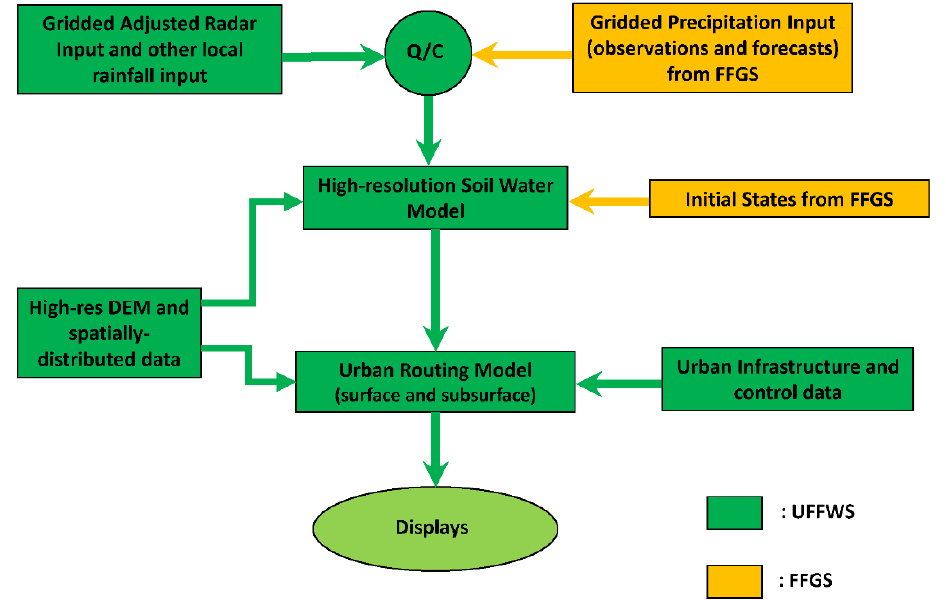
Figure 14. Data exchange between FFGS and UFFWS